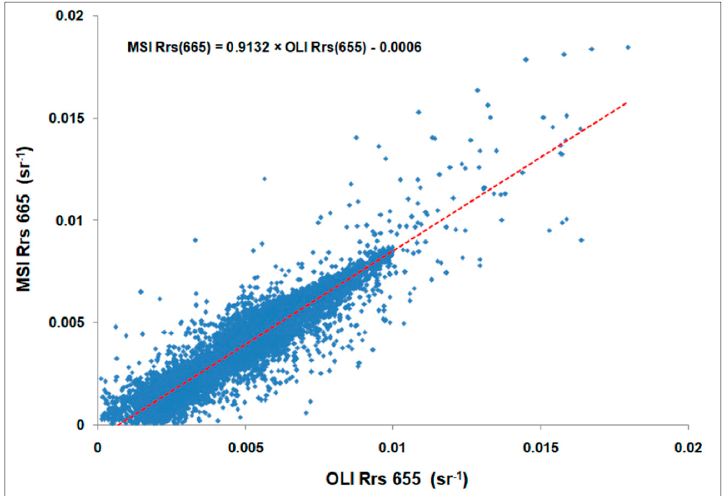
Figure 8. Scatter plot of MSI-S2A-derived Rrs ( 665 ) and OLI-L8-derived Rrs ( 655 ) for all the water pixels available (N = 11,977) within the 4 days considered. The superimposed equation is the linear “best-fitting” function (dashed red line).